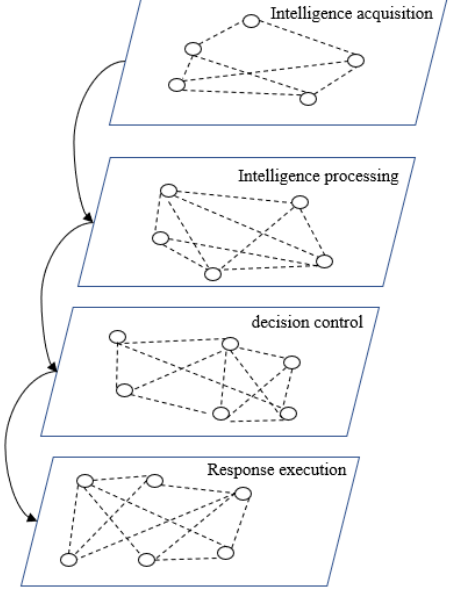
Figure 2. Missions at different layers.